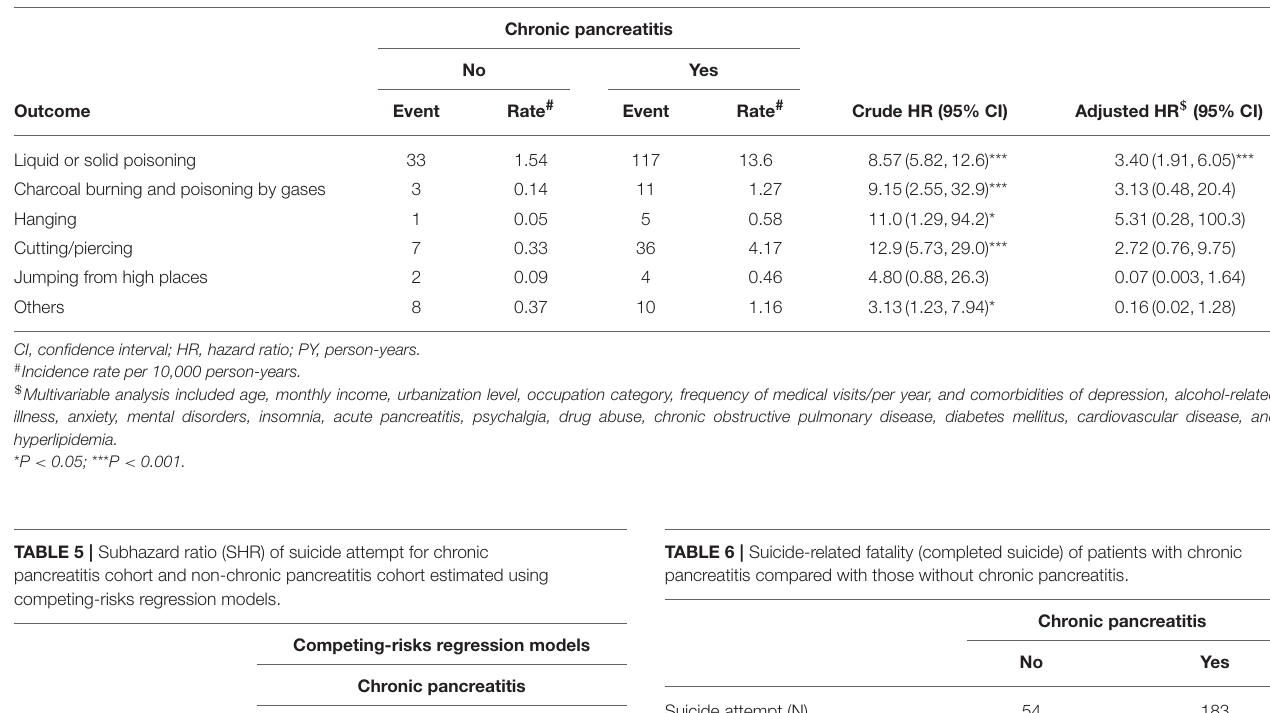
TABLE 4 | Incidence and hazard ratios of different types of suicide behavior between individuals with and without chronic pancreatitis.